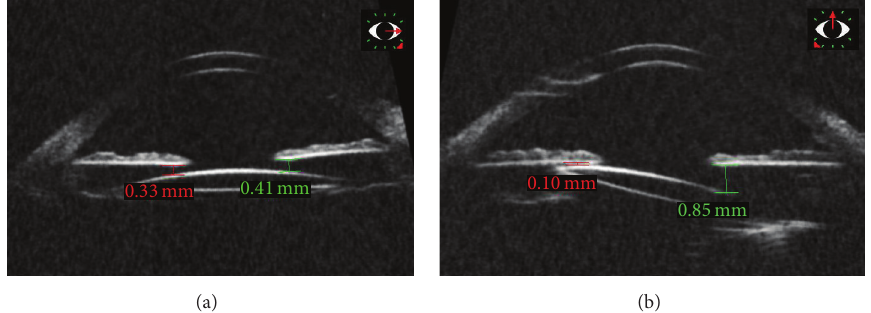
Figure 1: Ultrasound biomicroscopy of the left eye submitted to intraocular lens fixation using ab externo technique. (a) Horizontal plane showing good lens positioning; (b) vertical tilt of the IOL, lens placed more posteriorly in the superior meridian compared to the inferior